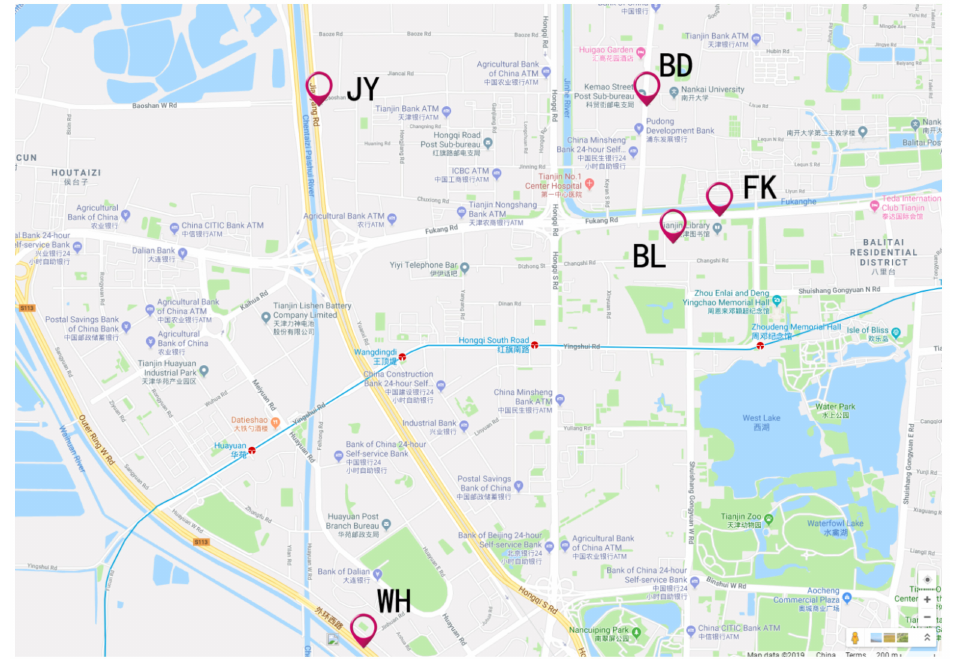
Figure 1. Location of sampling